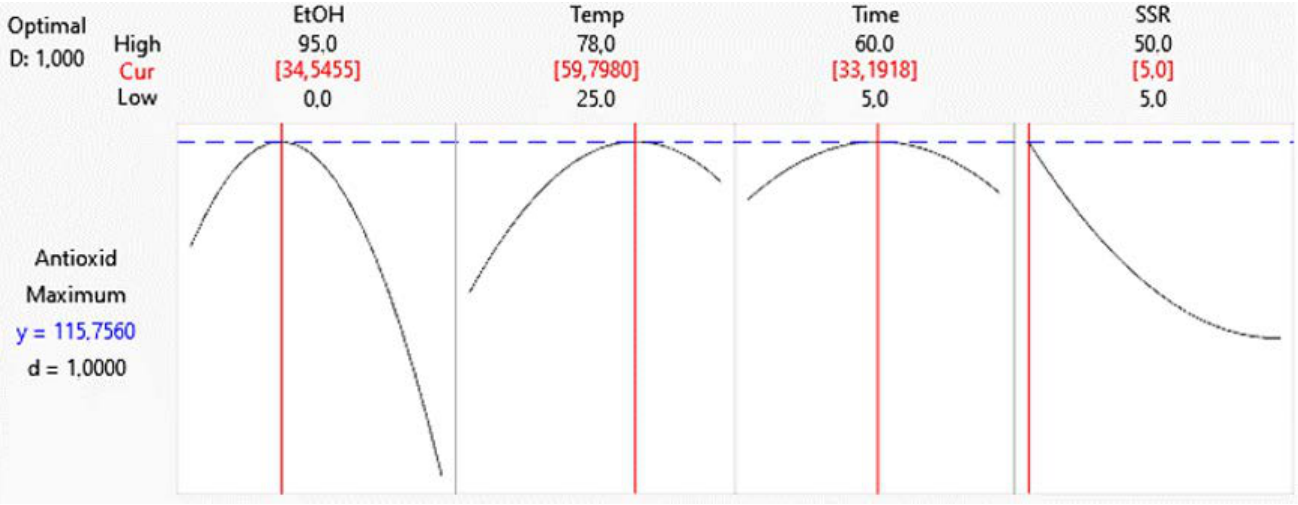
Figure 3. Optimized variables of the extraction of antioxidant compounds from Hibiscus sabdariffa